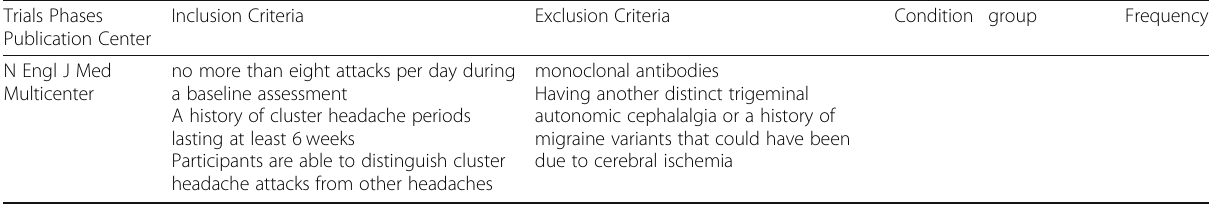
Table 1 Characteristics of the Included Studies and Outcome Events (Continued)